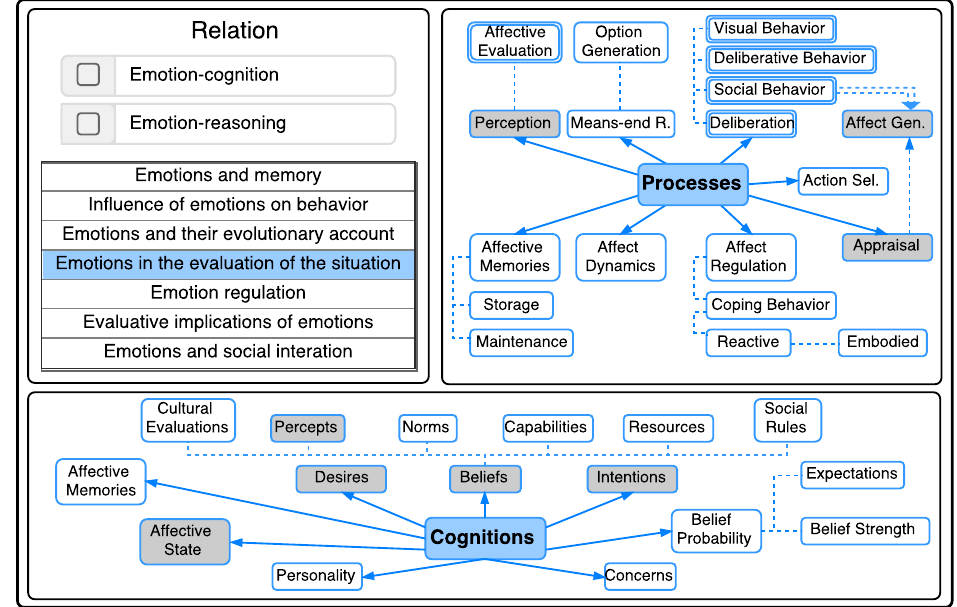
Figure 7. Processes and cognitions of the formalization of OCC